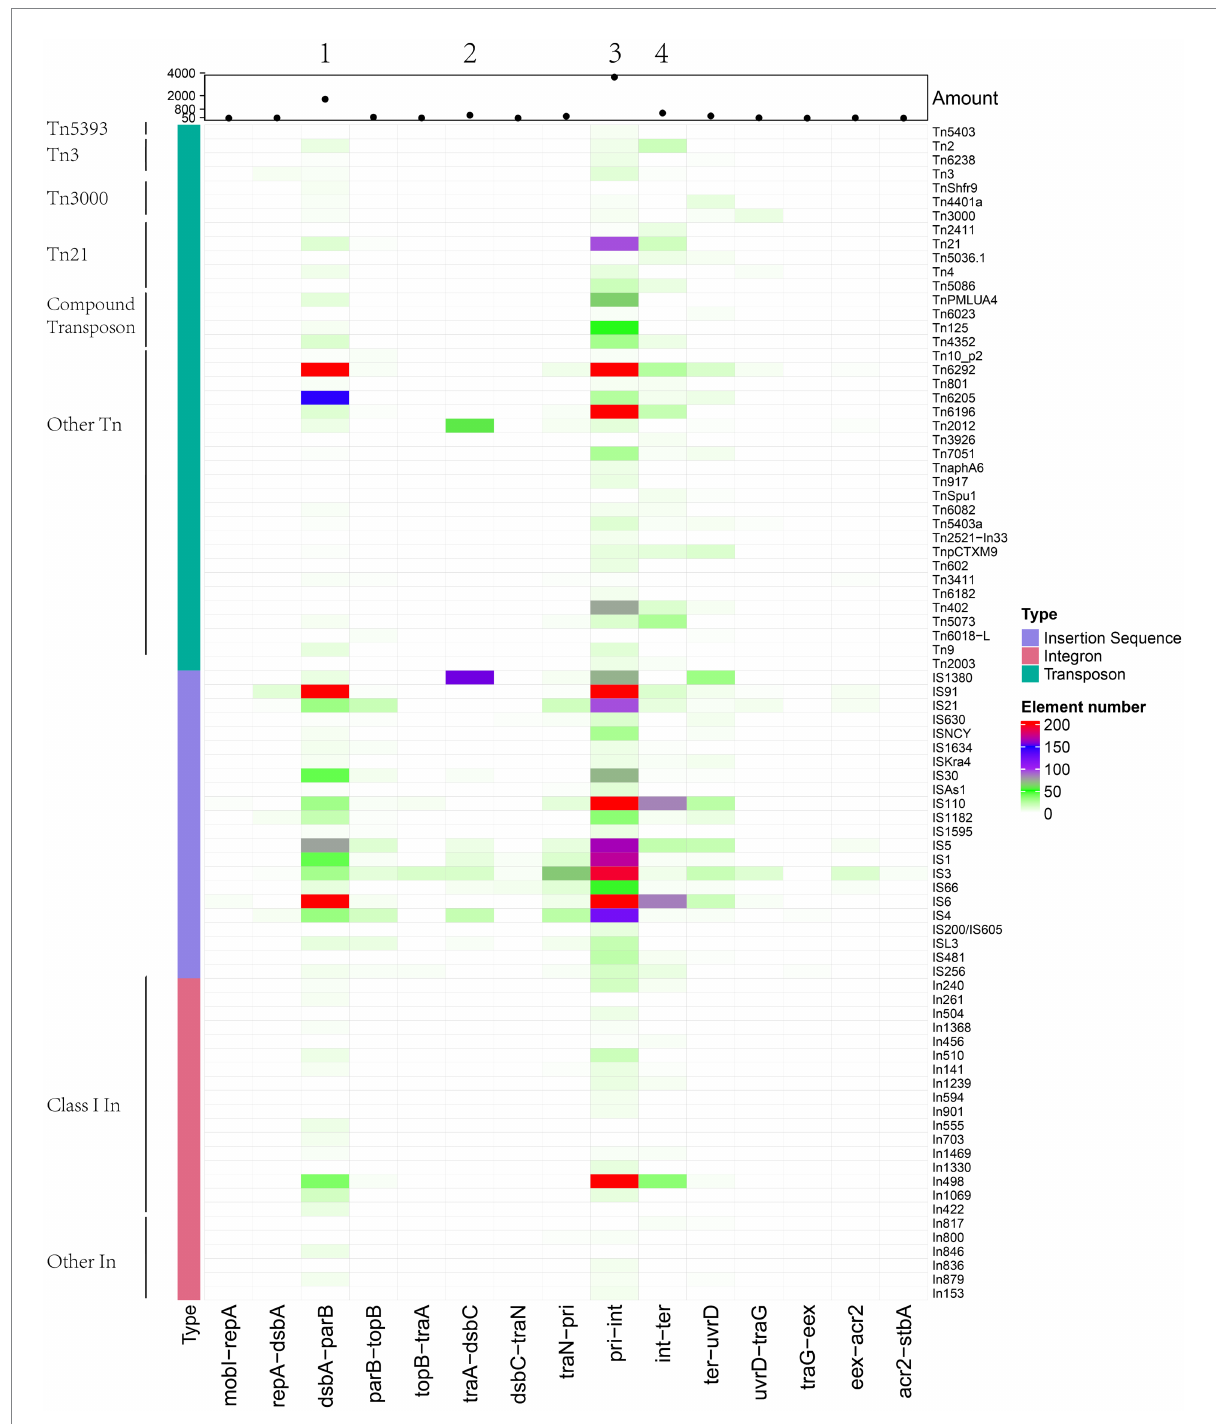
FIGURE 7 Heatmap of mobile genetic elements, including transposons, integrons and insertion sequences (amount > =3) in IncA and IncC plasmids. Their abundance is shown by the scatter plot, and group information is